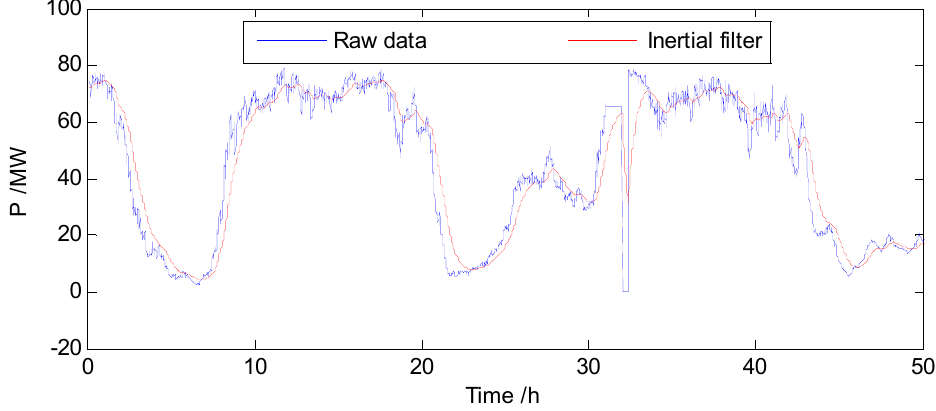
Figure 6. The smoothed power curve by Inertial Filter when T is 1800